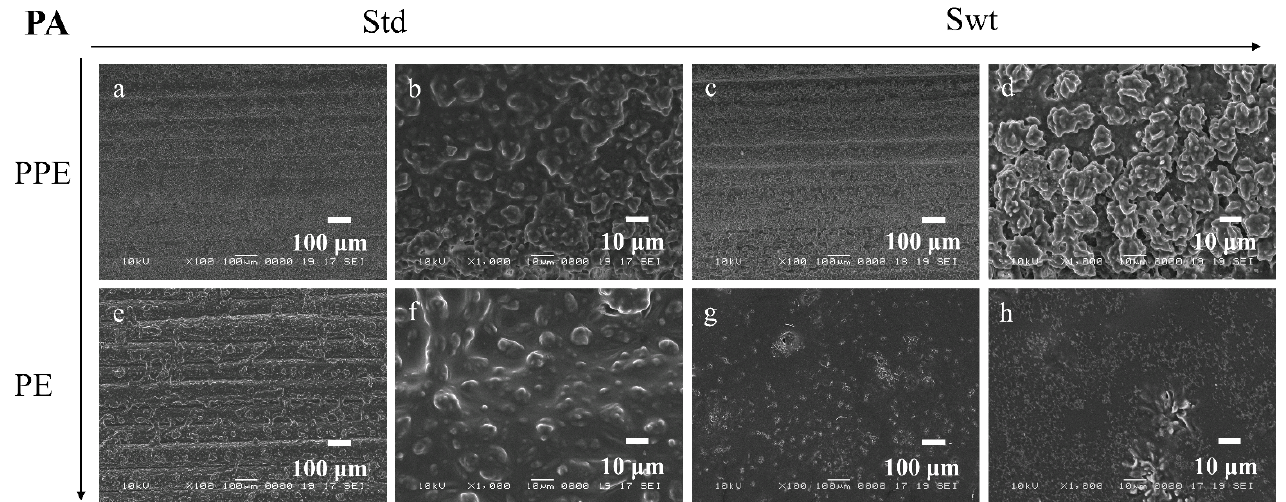
Figure 10. SEM images of PA biofilms in standard ( a , b , e , f ) and switched ( c , d , g , h ) samples on ( a ) × 100, ( b ) × 1000, ( c ) × 100, and ( d ) × 1000 PPE side; ( e ) × 100, ( f ) × 1000, ( g ) × 100, and ( h ) × 1000 PE side of the channel.